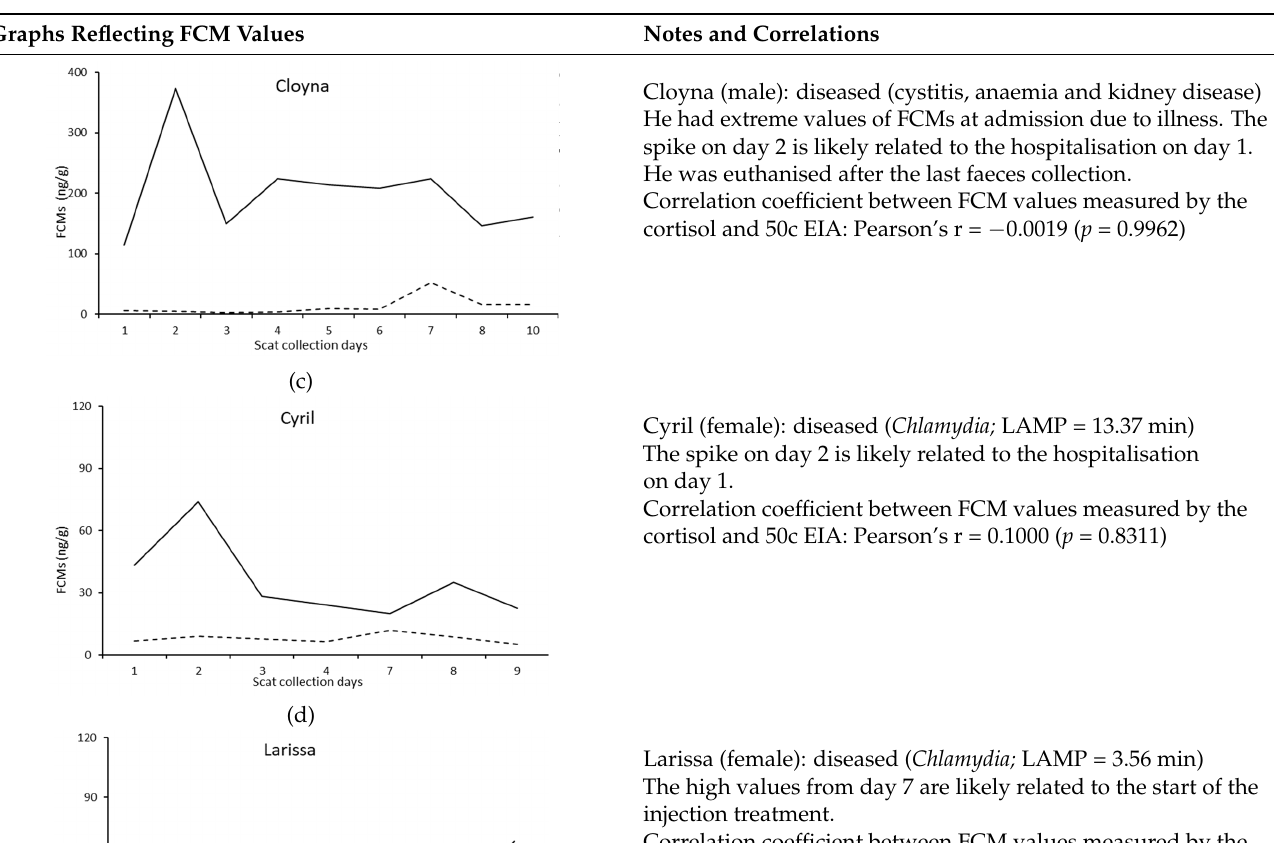
Table A2. Cont. Graphs Reflecting FCM Values Notes and Correlations